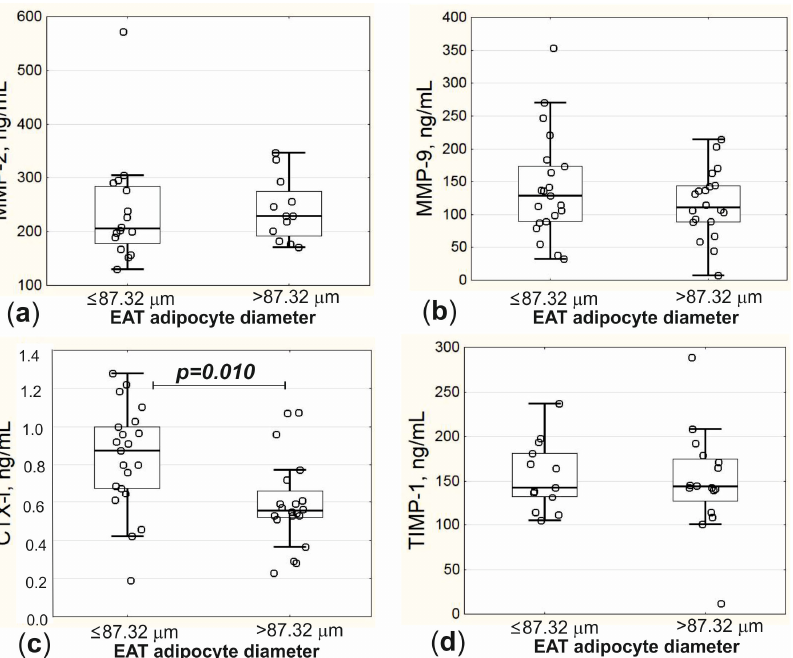
Figure 3. Serum concentrations of components of extracellular matrix remodeling in patients with EAT adipocyte diameter ≤ 87.32 μ m and > 87.32 μ m. ( a ) Concentration of MMP ‐ 2; ( b ) concentra ‐